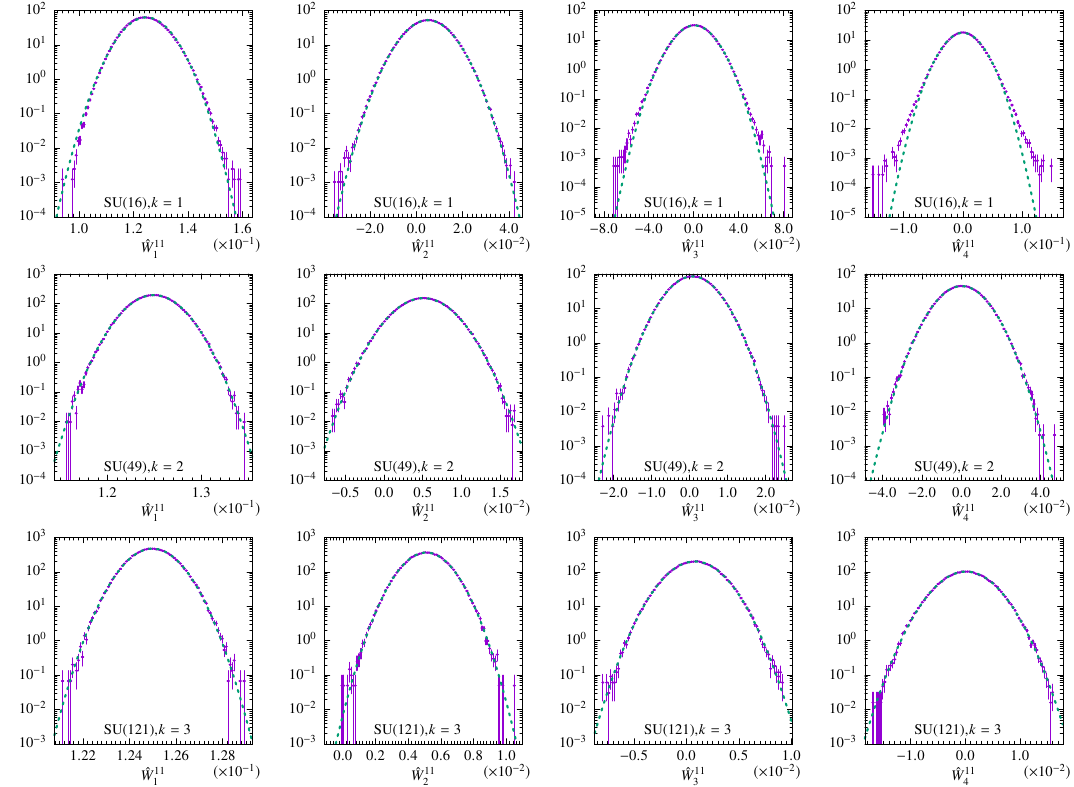
Figure 5. Histogram of ^ W 11 at ‘ = 1 ; 2 ; 3 ; 4 from left to right (top row: N = 16, middle: N = 49, ‘ bottom: N = 121). Results from N MD =